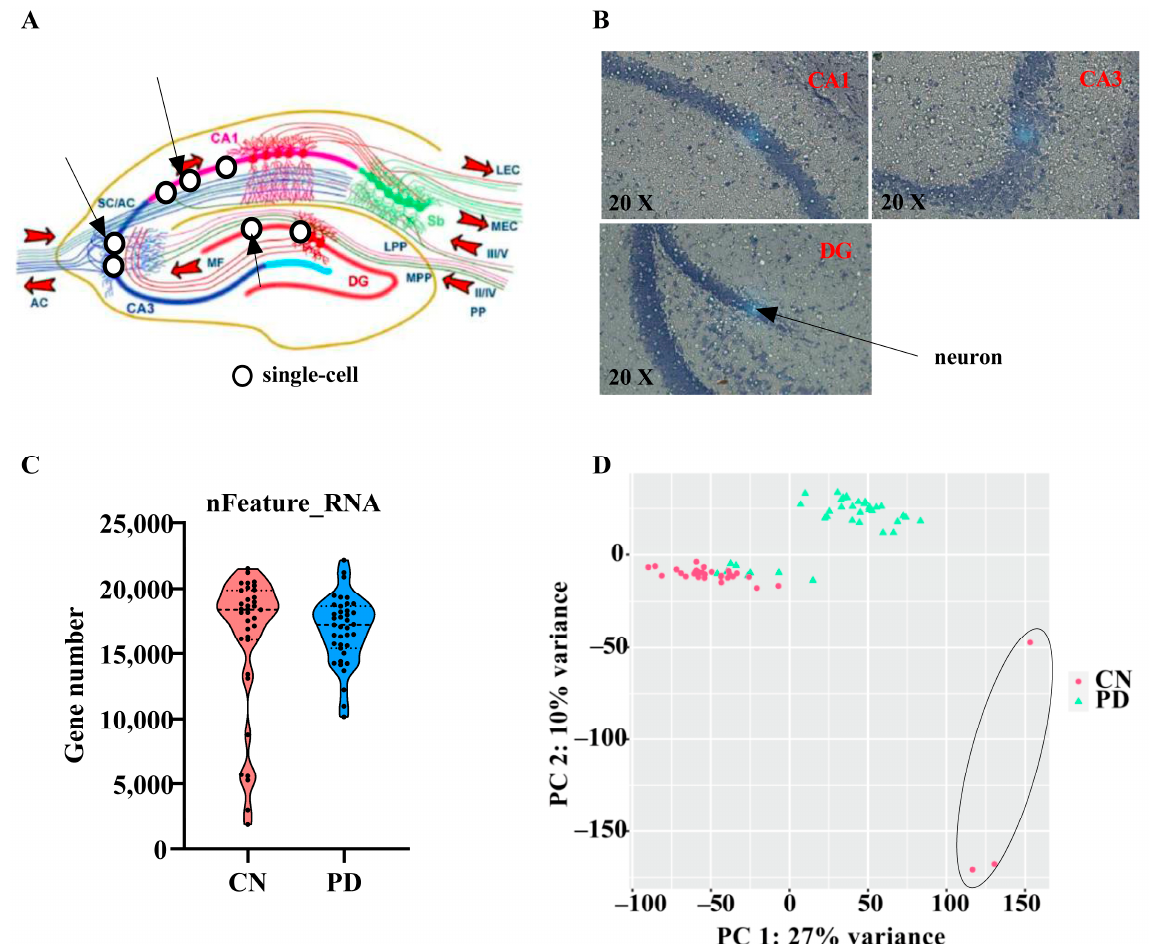
Figure 1. Schematic diagram for obtaining single cells. ( A ) A schematic diagram of the hippocampal formation. ( B ) Brain tissue sections stained with cresol violet. ( C ) Scatterplot illustrating the number of genes in each cell of PD and CN group. ( D ) Principal component analysis of all single-cell samples. CN: control; PD: Parkinson disease.